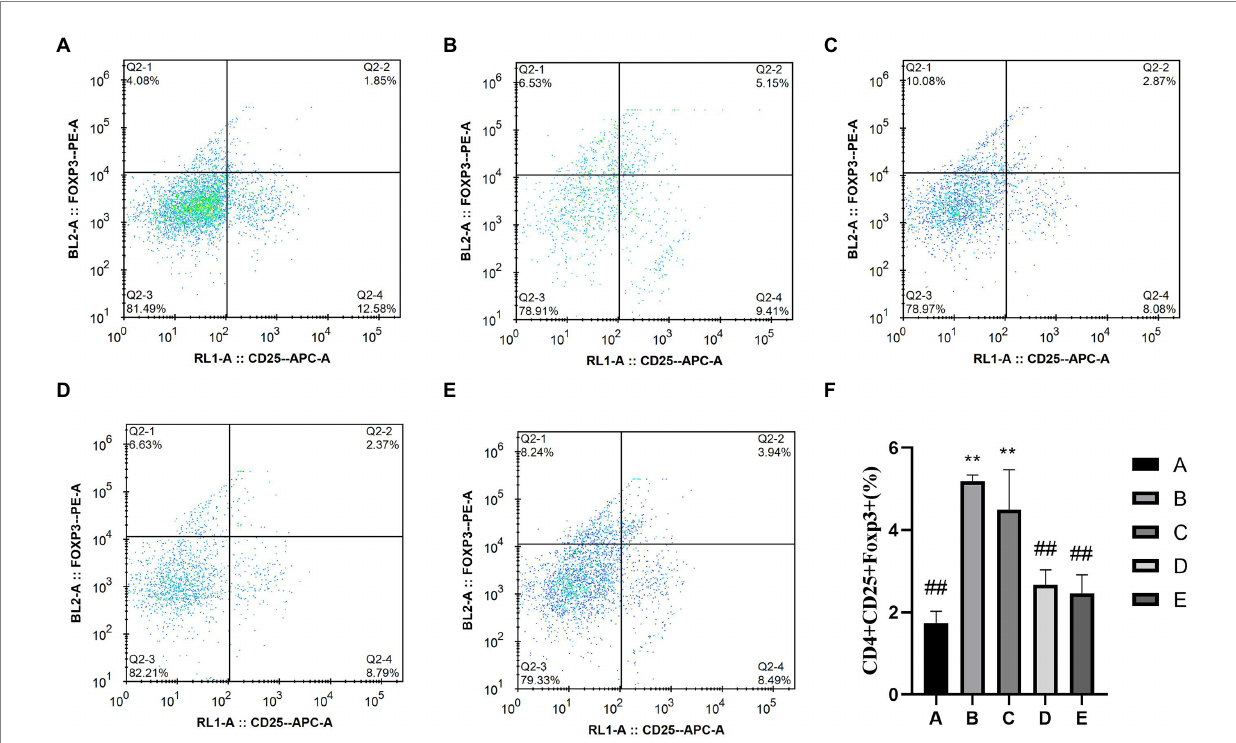
FIGURE 6 Effects of CSPCM on the percentage of Treg cells in Mesenteric lymph nodes. (A) The percentage of Treg cells in group A. (B) The percentage of Treg cells in group B. (C) The percentage of Treg cells in group C. (D) The percentage of Treg cells in group D. (E) The percentage of Treg cells in group E. (F) Effect of CSPCM on percentage of Treg cells in each